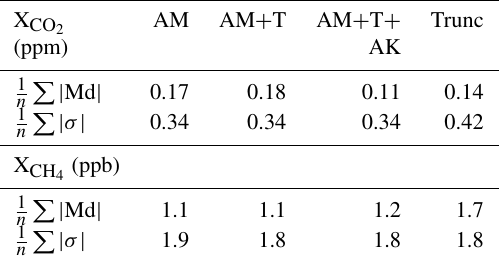
Figure 8. TCCON X air compared with mFTS X air within ± 2h of local noon. The differences are scaled by 1.001 to be centered about zero. X air can be used as a diagnostic for misalignments, timing, or surface pressure errors. Table 3. Mean differences pre- and post-adjustment for ± 2h of lo- cal